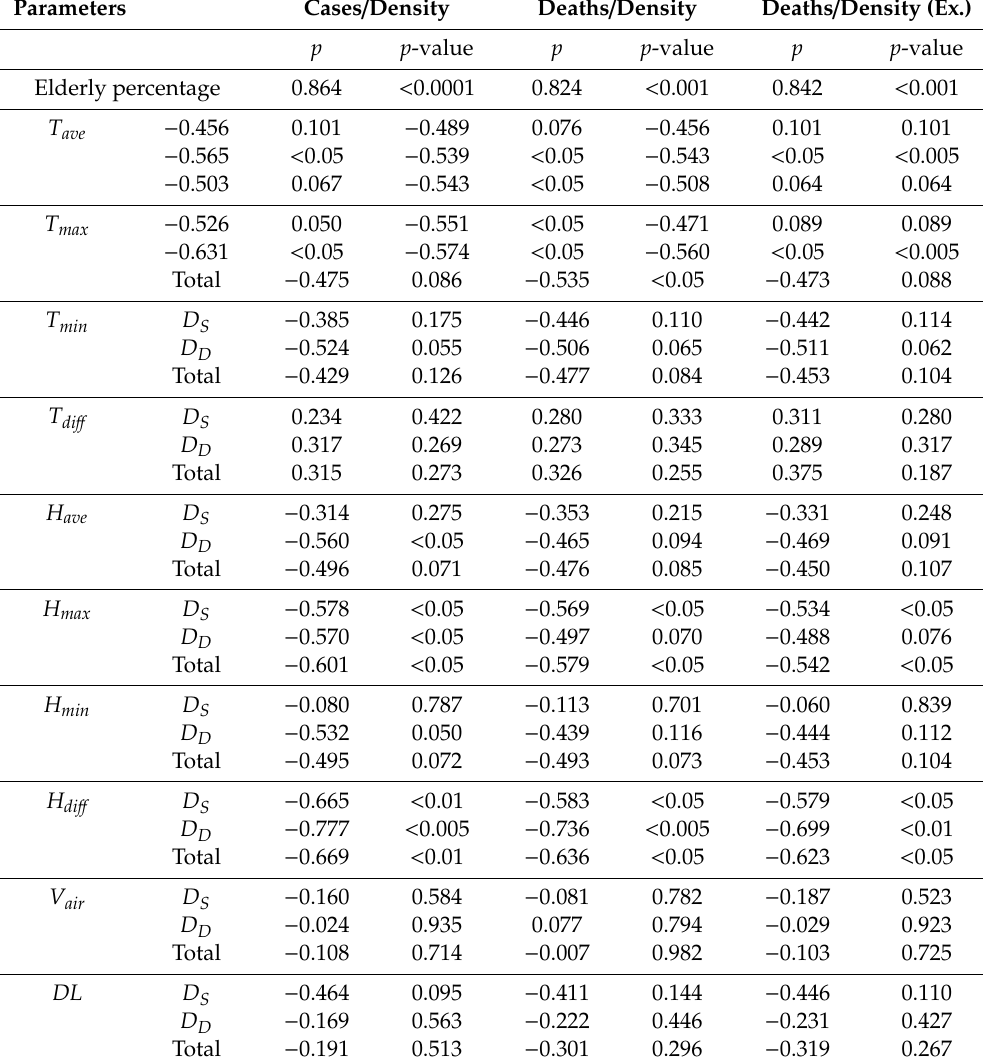
Table 5. Spearman’s rank correlation for cases normalized by density, death normalized density, and death, excluding nosocomial infection normalized by population